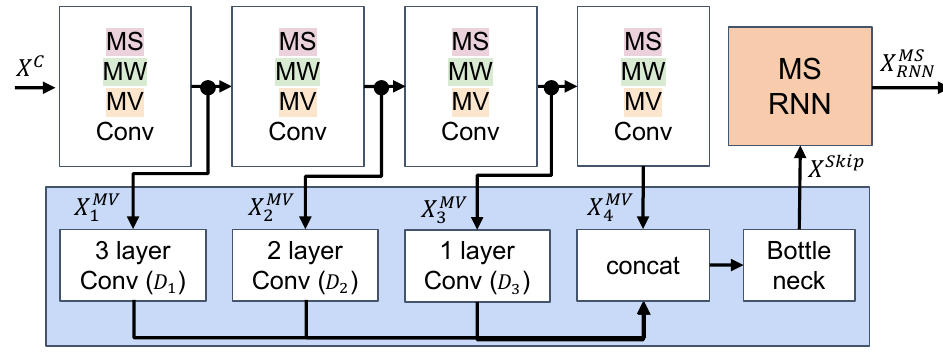
Figure 6. MSMVMW-Conv model with skip connections and temporal aggregation through multi- scale recurrent neural network. To handle vanishing gradients at the bottom layers of the MSMVMW- Conv model, skip connections are introduced to directly feed feature representations from intermedi- ate layers as auxiliary inputs to the classifier (blue). In this example, feature representations from each intermediate layer are processed by the multi-layer convolutional neural network with max-pooling to match the size of the feature representation from the final layer. The fused features from all convolutional layers are passed to the multi-scale recurrent neural network model for temporal aggregation and classification